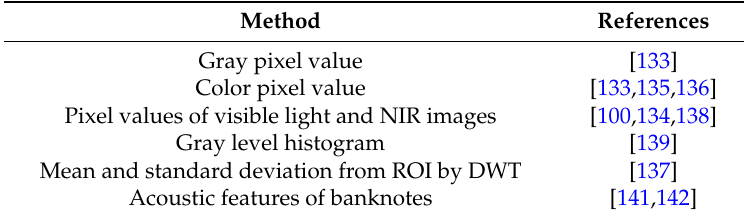
Table 15. Methods for feature extraction in the fitness classification process flow.